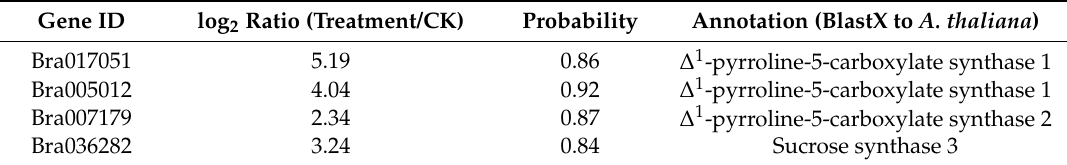
Table 4. The up-regulated DEGs encoding proteins related to osmolyte synthesis in Chinese cabbage. Gene ID log 2 Ratio (Treatment/CK) Probability Annotation (BlastX to A. thaliana